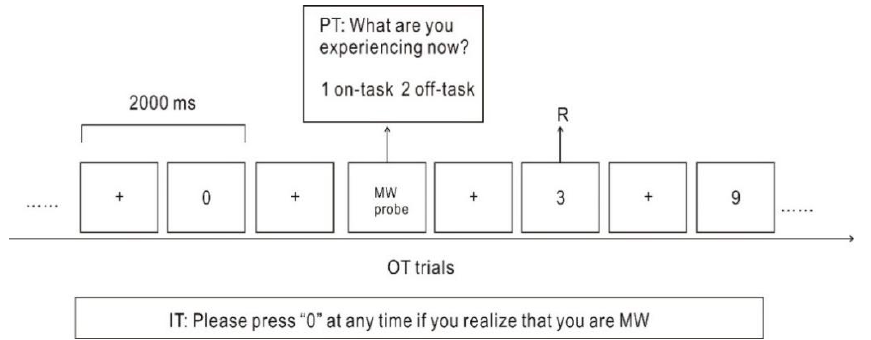
Figure 1. The modified sustained attention to response task (mSART). OT: on-going task. PT: passive task. IT: introspective task. Participants were required to press button “1” every time a digit except “3” appeared on the screen. Participants were asked to press the button “0” as soon as they realized they were MW (self-caught MW). When the probe appeared on the screen, if participants selected “off-task”, this indicated that they were MW (probe-caught MW).